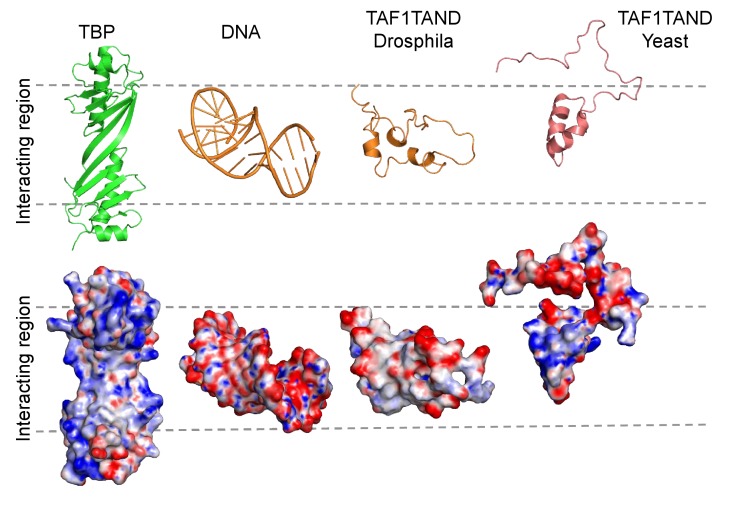
TAF1-TAND TATA-box mimicry in Drosophila and Yeast.Cartoon representation (top row) and electrostatic surface potential (bottom row) of TBP (left, PDB ID: 1TBP), TATA-DNA (PDB ID: 1CDW), and TAF1-TAND from Drosophila (PDB ID: 1TBA) and Yeast (PDB ID: 4B0A). The DNA-binding surface of TBP is shown (left), as well as the corresponding complementary surfaces of the interactors (right). Red indicates regions with negative charge, blue indicates regions with positive charge. The shape and surface charge similarity between Drosophila TAF1-TAND and TATA-DNA is evident (‘TATA-box mimicry’) but is less pronounced in TAF1-TAND from yeast. Yeast TAF1-TAND binding is more extensive involving also the convex surface of TBP (Table 5).